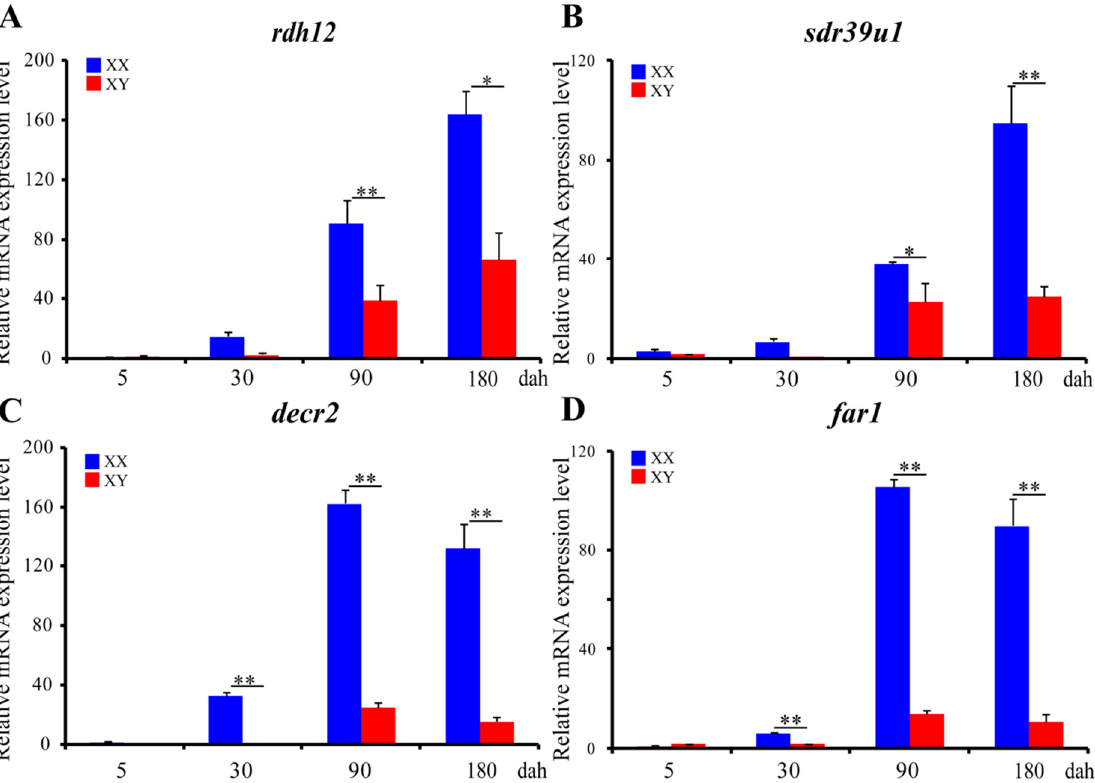
Figure 8. Ontogeny expression of rdh12 ( A ), sdr39u1 ( B ), decr2 ( C ), and far1 ( D ) in gonads at 5, 30, 90, and 180 dah analyzed by qPCR (n = 3). eef1a1a was used as internal control. Data were expressed as the mean ± SD. “*” and “**” above the error bar indicate statistically significant differences between XX and XY gonad at p < 0.05 and p < 0.01 by Student’s t- test, respectively. All examined genes displayed similar expression profiles to those from the transcriptome data.